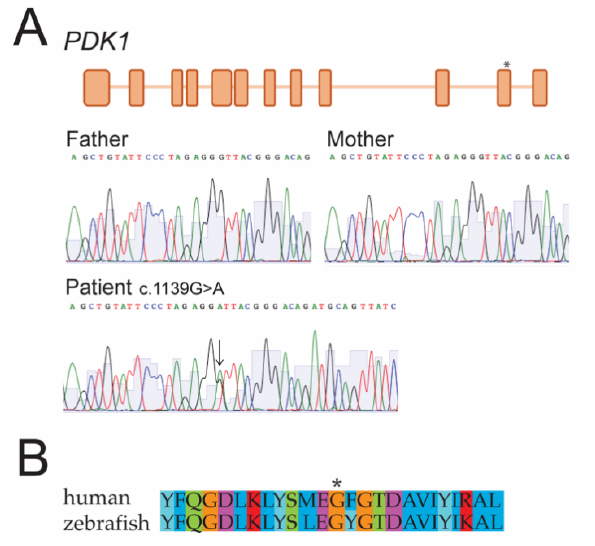
Figure 1. ( A ) Genome analysis revealed a de novo variant in PDK1 . Whole genome sequencing showed a c.1139G > A (p.G380D) variant in exon 11 of PDK1 (*) in heterozygosity (arrow). Sanger sequencing of the parents and the proband confirmed it was a de novo variant. ( B ) Partial amino acid sequence alignment including the amino acid affected by the variant (*) shows conservation between human and zebrafish.